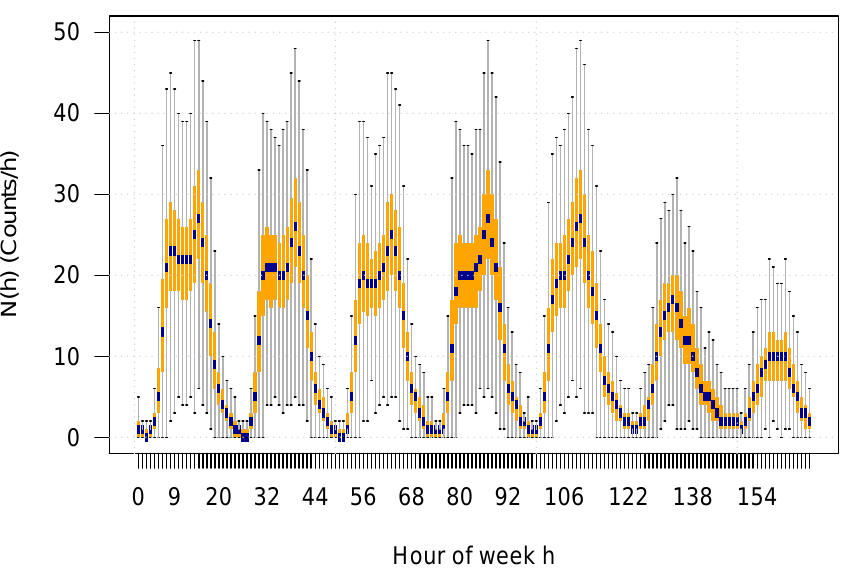
Figure 2. Box plot of the crash frequency per hour of the week. The blue bar is the median, the boxes are the 25- and 75-percentiles, the whiskers display the minimum and the maximum of the data.